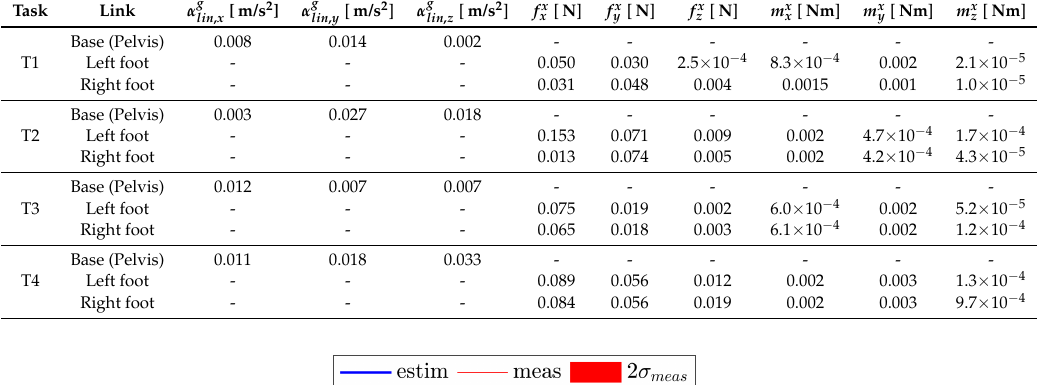
Table 2. RMSE analysis of the base linear proper sensor acceleration α g [ N] and moment m x [ Nm] floating-base algorithm estimations w.r.t. the measurements, for tasks T1, T2, T3 and T4.